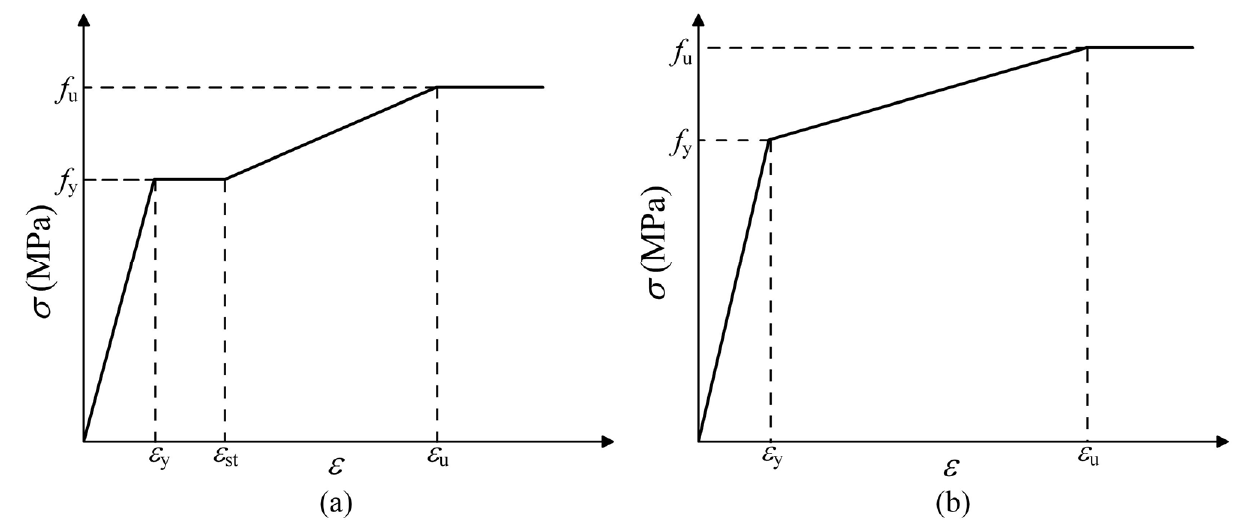
Figure 3. Stress–strain relationship of high-strength steel: ( a ) with yield platform and ( b ) without yield platform.